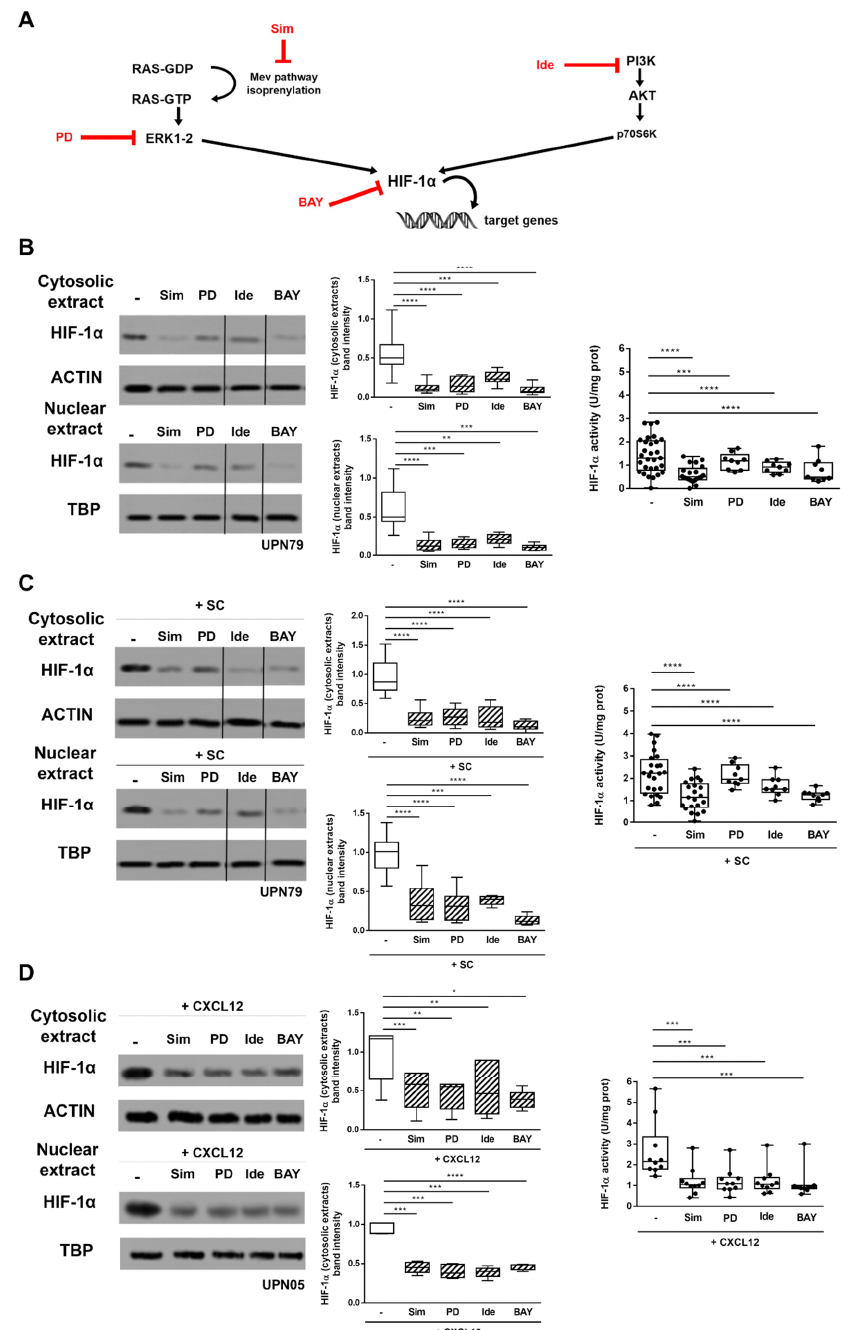
Figure 2. Targeting the RAS/ERK1-2 and PI3K/AKT signalling inhibits SC- and CXCL12-induced HIF-1 α upregulation. A schematic representation of RAS/ERK1-2 and PI3K/AKT HIF-1 α regulatory pathways, and the target protein of each inhibitor used in the following experimental setting (i.e., simvastatin, Sim; PD98059, PD; idelalisib, Ide; BAY87-2243, BAY) is depicted in ( A ). CLL cells cultured for 48 h in the absence ( B ) and in presence of M2-10B4 SC ( C ) or CXCL12 ( D ) were exposed to simvastatin, PD98059, idelalisib or BAY87-2243 and evaluated for HIF-1 α expression and activity. Treatment with targeted inhibitors reduced the cytosolic and nuclear amount of HIF-1 α and downregulated its activity, both in the absence and in the presence of SC or CXCL12. In ( B – D ) a representative blot with UPN and cumulative band intensity data obtained from the analysis of 9, 9 and 5 independent experiments, respectively, is shown. Repositioned gel lanes are indicated by vertical lines. Box and whiskers plots show median values, 25–75% percentiles, and minimum and maximum values for each group; each point represents a single sample. **** p < 0.0001, *** p < 0.001, ** p < 0.01 and * p < 0.05. Please find the whole western blot in the Supplementary File